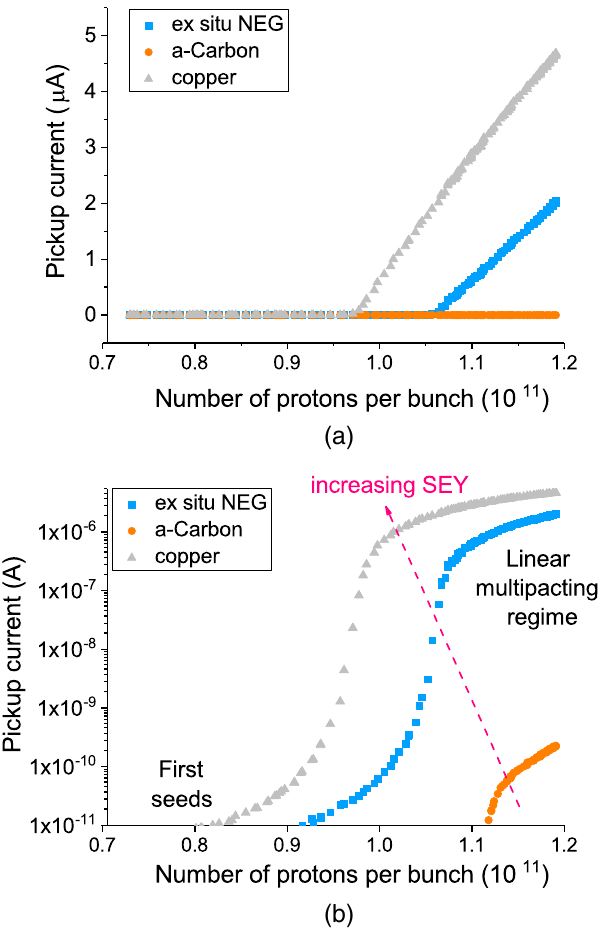
FIG. 6. Pressure trends as a function of the number of bunches during the injection phase at 450 GeV of a 25-ns standard LHC beam in linear scale.